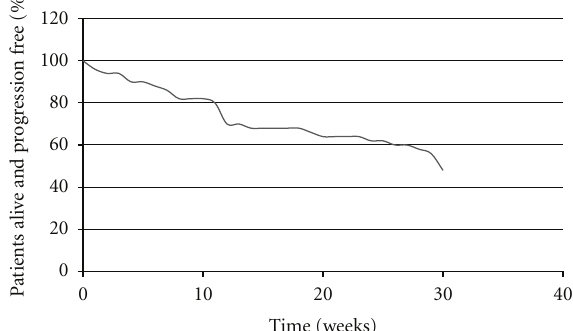
Table 1: Baseline patient characteristics.